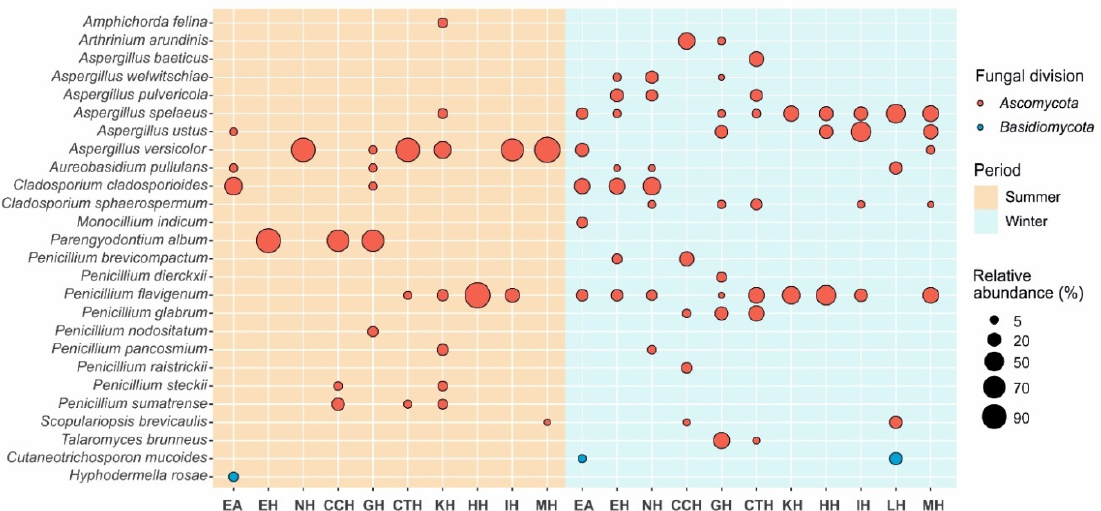
Figure 3. Bubble Plot. Most abundant fungi, as distributed in each sampling point (EA: Outside, EH: Entrance Hall, NH: Nativity Hall, CCH: Cascade Hall, GH: Ghosts Hall, CTH: Cataclysm Hall, KH: Kitchen Hall, HH: Heracles Hall, IH: Immensity Hall, LH: Lance Hall, MH: Mountain Hall) and period (summer and winter).